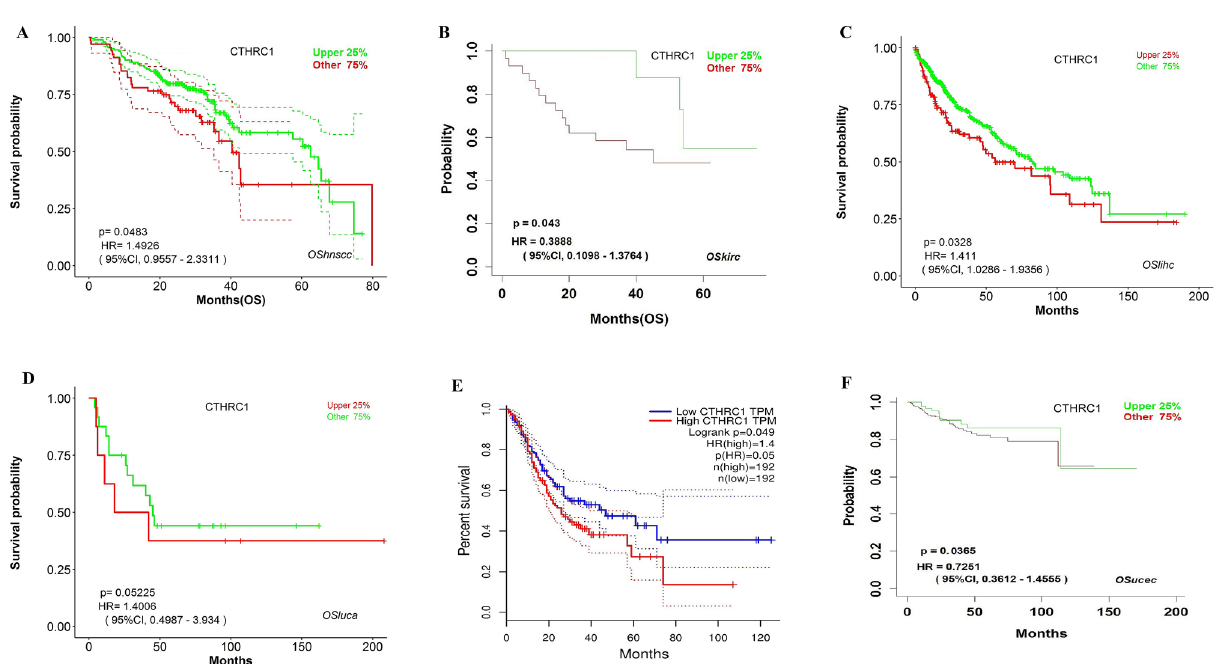
Figure 3. The validation of CTHRC1 prognostic values in HNSC, KIRC, LIHC, LUAD, STAD, and UCEC. ( A ) Prognostic value of CTHRC1 in HNSC using OShnscc database, ( B ) Prognostic value of CTHRC1 in KIRC using OSkirc database, ( C ) Prognostic value of CTHRC1 in LIHC using OSlihc database, ( D ) Prognostic value of CTHRC1 in LUAD using OSluca database, ( E ) Prognostic value of CTHRC1 in STAD using GEPIA database, and, ( F ) Prognostic value of CTHRC1 in UCEC using OSucec database. The red color in Kaplan–Meier plots shows the higher expression of CTHRC1 while green and blue color indicates the lower expression. The x-axis represents survival time and the y-axis represents survival